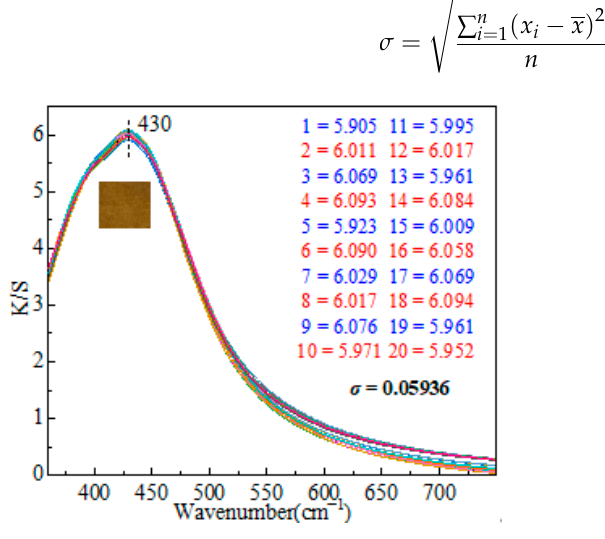
Figure 5. K/S spectrum of fabrics.